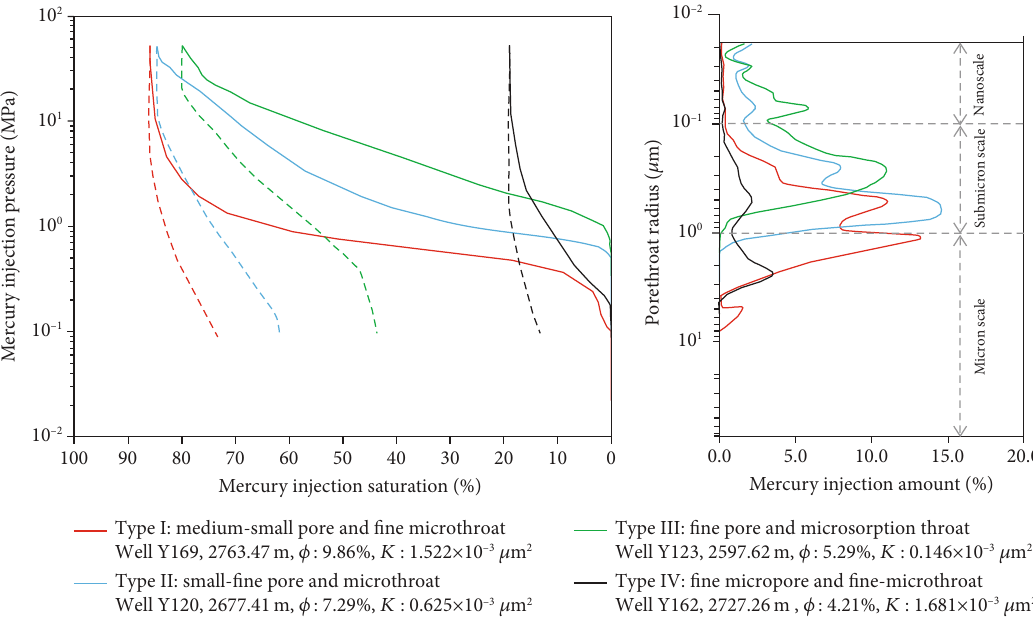
Figure 5: Characteristics of mercury intrusion curves and pore structure of samples in the research